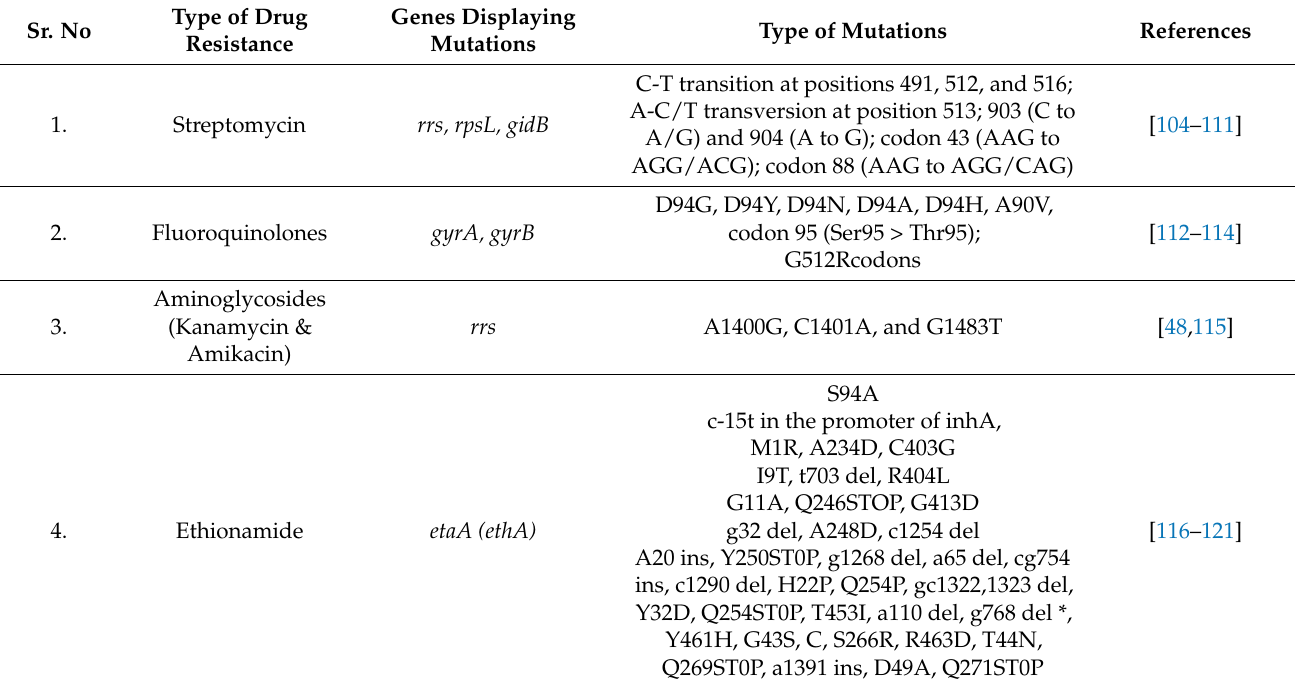
Figure 2. The mechanism for acquired drug resistance in Mtb . Table 2. Types of genetic mutations in mycobacteria leading to resistance against second-line drugs. * Represents found in Drug-resistant and/or Drug-sensitive